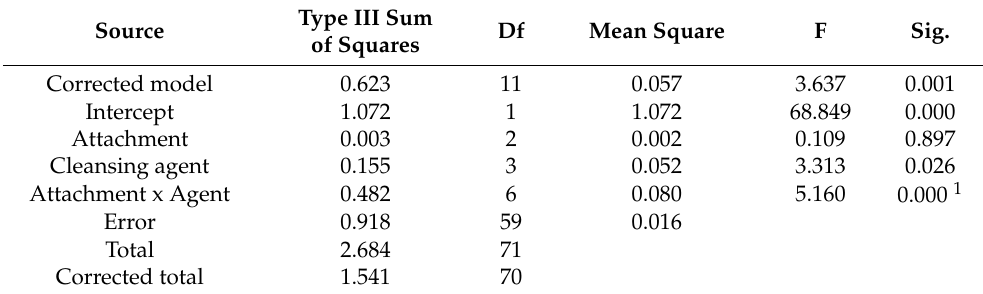
Table 3. Test of between-subject effects.